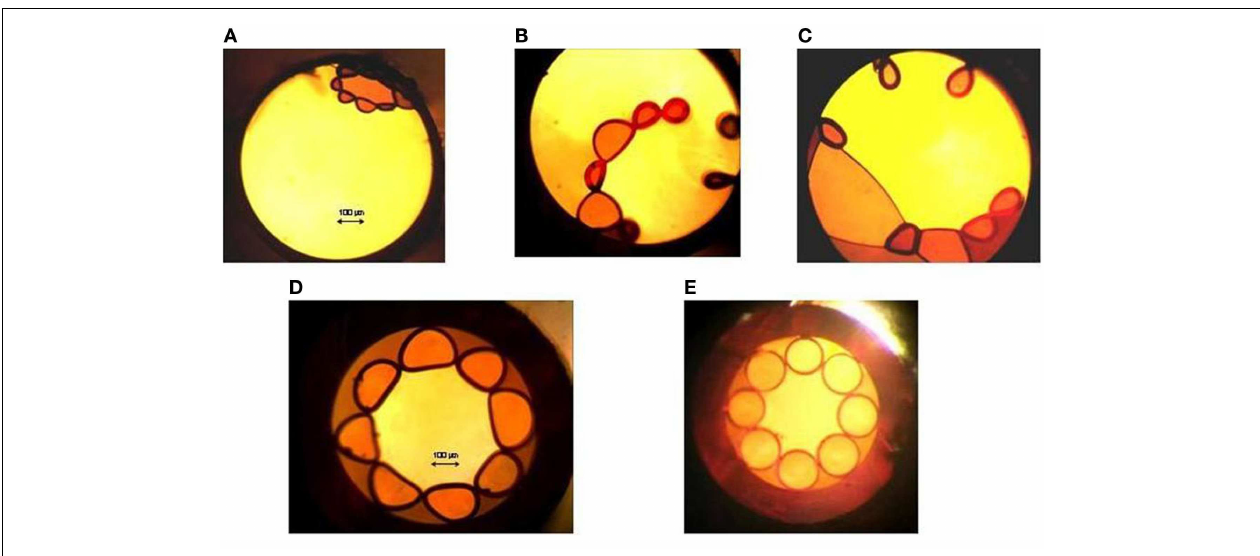
FIGURE 10 |The cross-sections ofAs 2 S 3 MOFs obtained under different drawing conditions .The temperature: (A–C) 330–340°C, (D) 320°C, (E) 310°C.The excess argon pressure in capillaries: (A) 0, (B) 100Pa, (C) 600Pa, (D) 1000Pa, (E) 4000Pa (Shiryaev et al., 2014b).